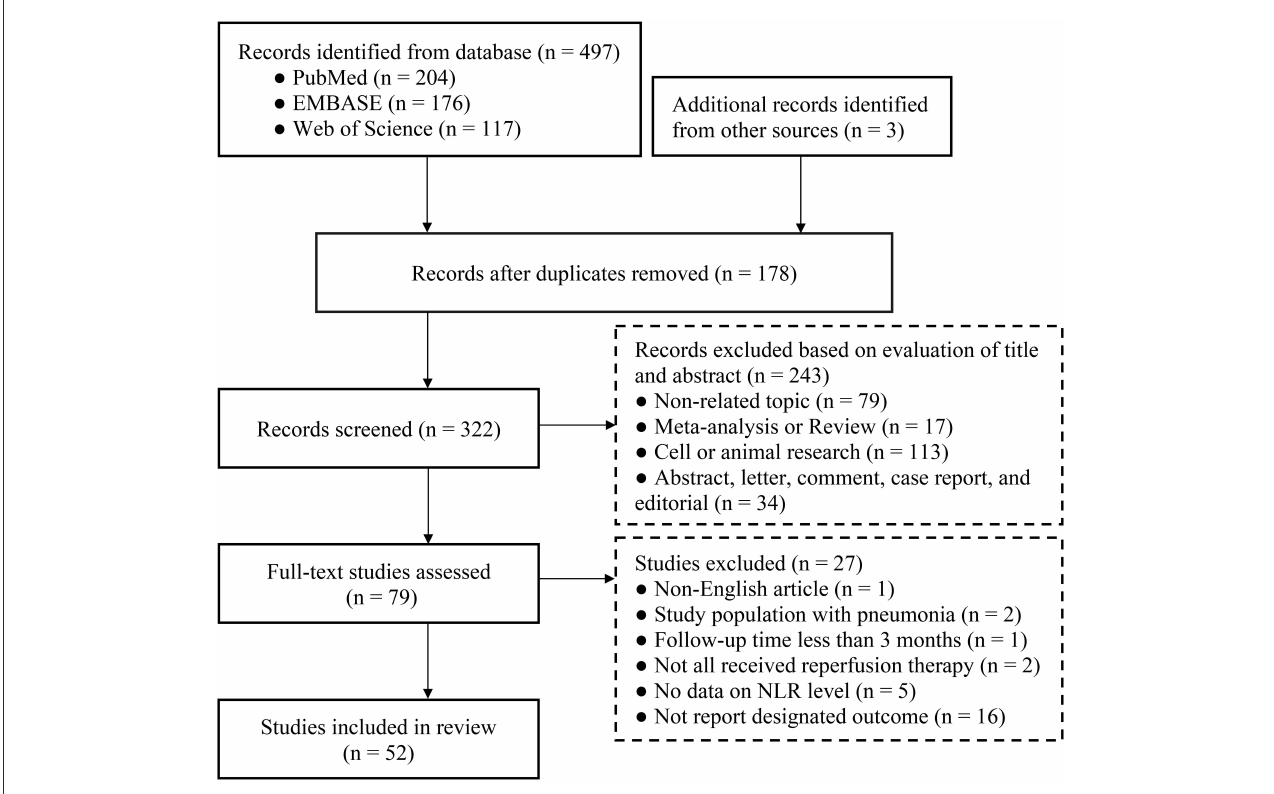
FIGURE1 Flow diagram of the study search and selection